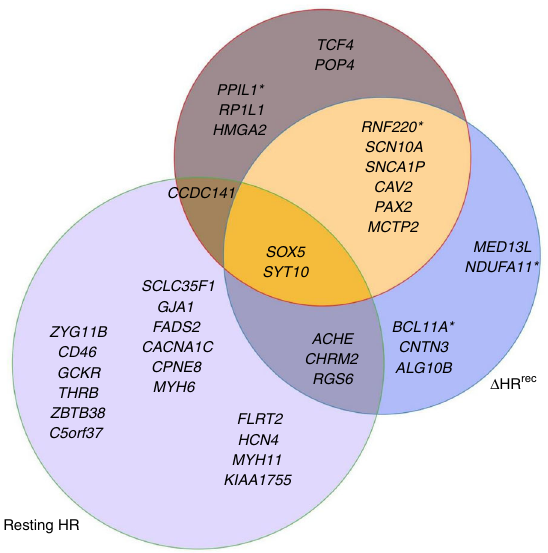
Fig. 3 Overlap of loci for Δ HR ex , Δ HR rec and resting HR in the full cohort GWAS. The locus names indicate the nearest annotated genes. A substantial number of loci associated with Δ HR ex and Δ HR rec were not associated with resting HR and vice versa. The loci SOX5 and SYT10 were identi fi ed in all three traits. *: indicates loci that have previously been associated with resting HR but did not reach genome-wide signi fi cance in our